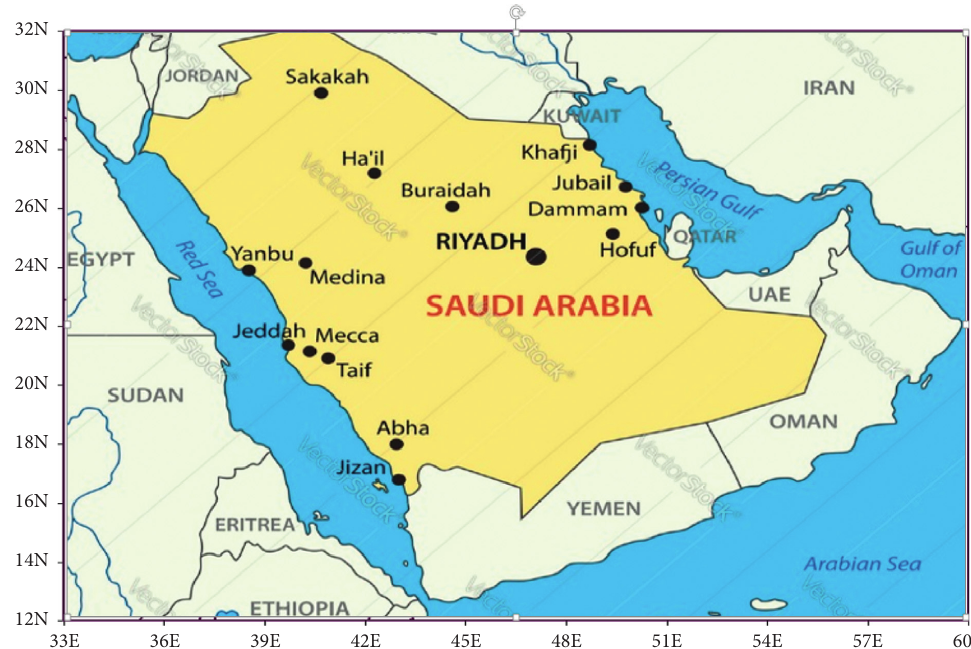
Figure 1: The map of the Arabian Peninsula, including Saudi